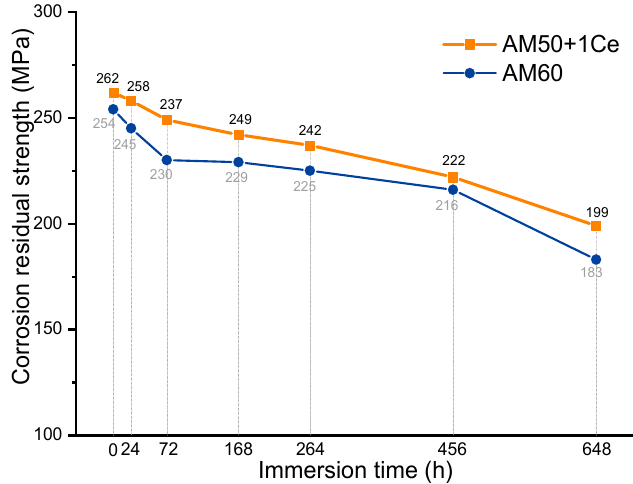
Figure 7. The engineering stress–strain curve of HPDC ( a ) AM50+1Ce and ( b ) AM60 magnesium alloys after corrosion test for different time immersing in 3.5wt% NaCl solution.